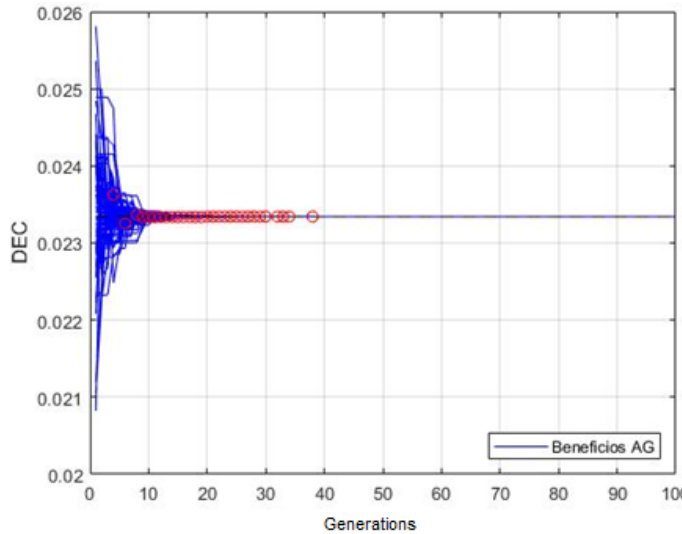
Figure 9. Estimated DEC values per